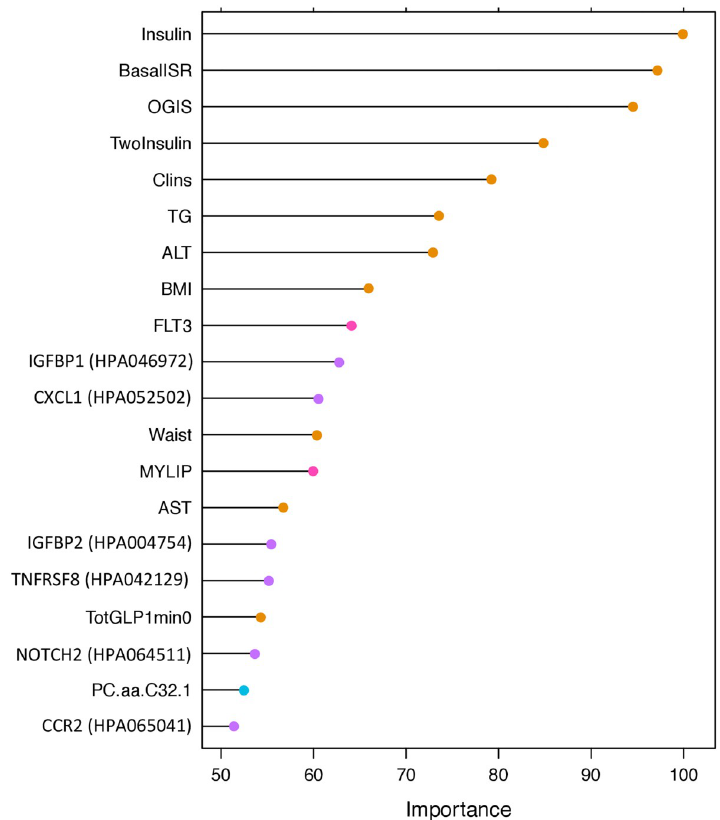
Fig 6. Variable importance for the advanced model 14 with 185 omics and clinical input variables (clinical = 22, genetic = 23, transcriptomic = 93, exploratory proteomic = 22, and targeted metabolomic = 25). The y -axis shows the top 20 predictors in the model. The x -axis shows the variable importance calculated, via a permutation accuracy importance measure using random forest analysis, as the difference in prediction accuracy before and after the permutation for each variable scaled by the standard error. ALT, alanine transaminase; AST, aspartate transaminase; BasalISR, insulin secretion at the beginning of the oral glucose tolerance test/mixed-meal tolerance test; BMI, body mass index; Clins, mean insulin clearance during the oral glucose tolerance test/mixed-meal tolerance test calculated as (mean insulin secretion)/(mean insulin concentration); FLT3, fetal liver tyrosine kinase-3; Insulin, fasting insulin from venous plasma samples; MYLIP, myosin regulatory light chain interacting protein; OGIS, oral glucose insulin sensitivity index according to the method of Mari et al. [24]; TG, fasting triglycerides; TotGLP1min0, concentration of fasting total GLP-1 in plasma; TwoInsulin, 2-hour insulin after oral glucose tolerance test/mixed meal tolerance test.